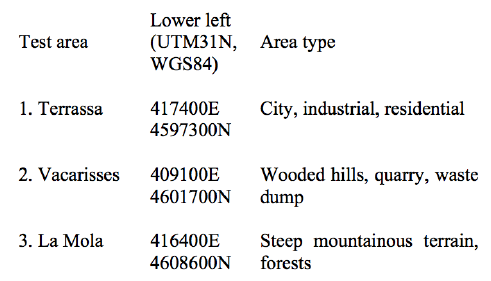
Figure 3: Test areas characteristics and position (in UTM